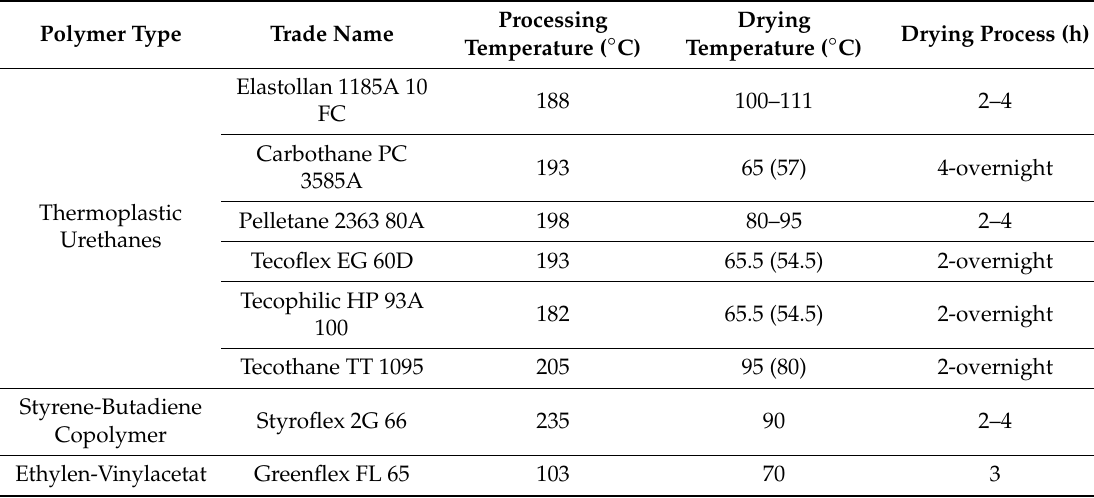
Table 1. List of the polymer types and processing parameters to produce flat